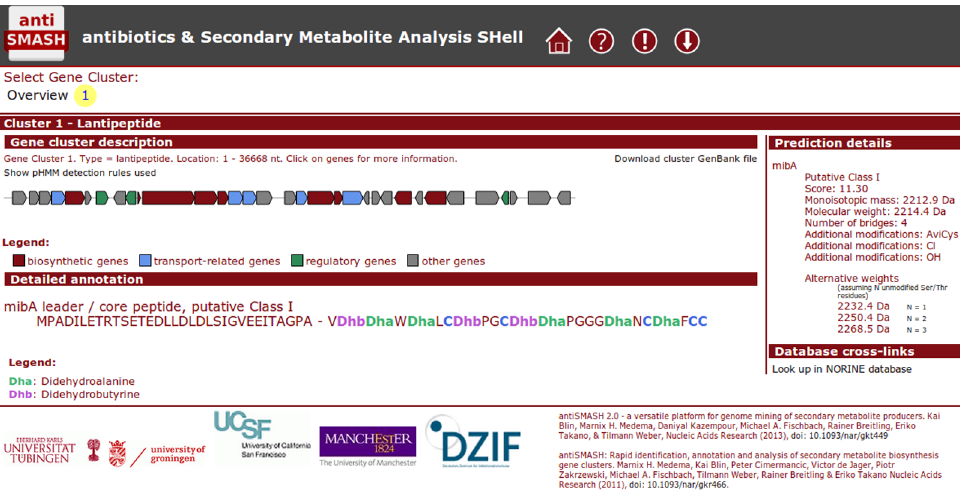
Figure 1. Example lanthipeptide output antiSMASH 2.2 output for the microbisporicin [ 5 ] gene cluster, showing the predicted leader/core peptide split and the predicted tailoring reactions and weights in the sidebar.